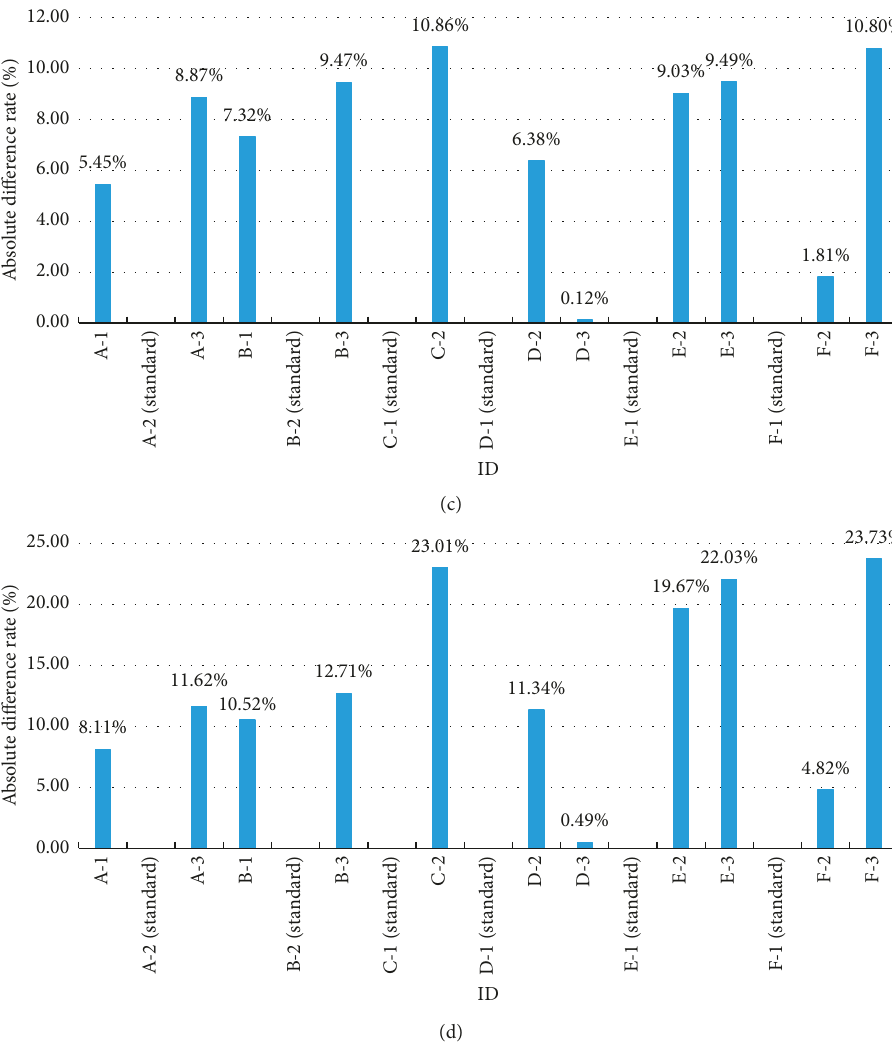
Figure 12: The comparison of stiffness deterioration. (a) Positive unloading stiffness. (b) Negative loading stiffness. (c) Negative unloading stiffness. (d) Positive loading